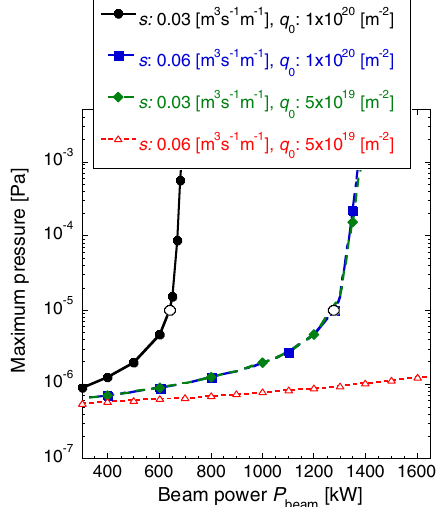
FIG. 22. Calculated dependence of the maximum pressure on the beam power for the combinations of two realistic s and q 0 values. The initial pressure is set to 5 × 10 − 7 Pa. The open circles represent the critical beam power P in each combination of beam cr s and q P for the combination of s : 0 values. The beam cr 5 × 10 19 m − 2 is out of range, which 0 . 06 m 3 s − 1 m − 1 and q 0 : is 2.6